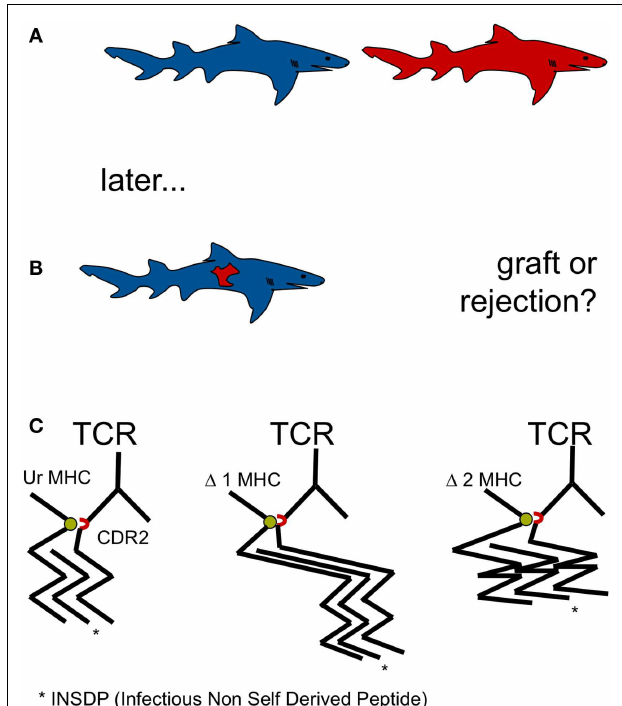
FIGURE 1 | (A,B) Allorecognition by adaptive cellular immunity by means of V(D)J recombination is restricted to gnathostomata. Allo-MHC recognition may be essential in carnivorous vertebrates for self defense. Devouring of raw meat of the same species containing viruses and other parasites represents a selective pressure for MHC recognition and the development of allorejection. Since agnathan shark prey such as lamprey and hagfish did not display MHC, selective pressure for allorecognition to defend individual genetic integrity occurred first, when sharks started eating sharks: cannibalism became a constitutive feature of this extant. (C) A single amino acid in theTCR CDR2 (red), conserved from shark to man and critical for MHC recognition (green) byTCR argues in favor of MHC recognition before peptide recognition and underlines the postulate of a germ line encoded, innate MHC bias of the randomTCR repertoire, located in MHC binding CDR1 and